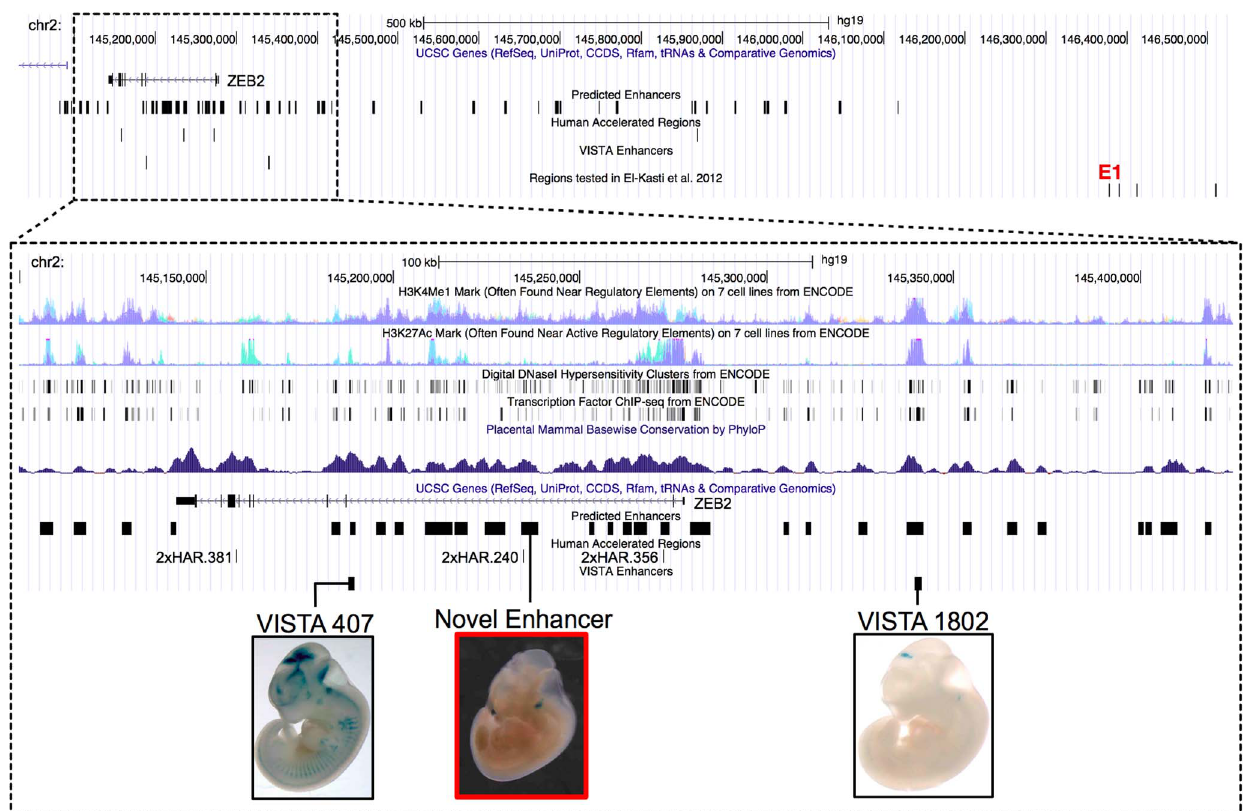
Figure 8. A novel cranial nerve enhancer in the ZEB2 locus. This UCSC Genome Browser snapshot shows a dense region of predicted enhancers in a 1.5 Mb window on human chromosome 2 including ZEB2 and part of the adjacent gene desert. Tracks give the locations of four human accelerated regions (HARs), two validated VISTA enhancers (hs407 and hs1802), and the E1 region recently shown to have postnatal enhancer activity [87]. The inset shows a zoomed in view of ZEB2 (hg19.chr2:145,100,000–145,425,000) along with summaries of several ENCODE functional genomics datasets and evolutionary conservation across placental mammals. We tested the predicted enhancer overlapping 2xHAR.240 for enhancer activity at E11.5 in transgenic mice. Both the human and chimp versions of this sequence drive consistent expression in the cranial nerve (Figure S11).